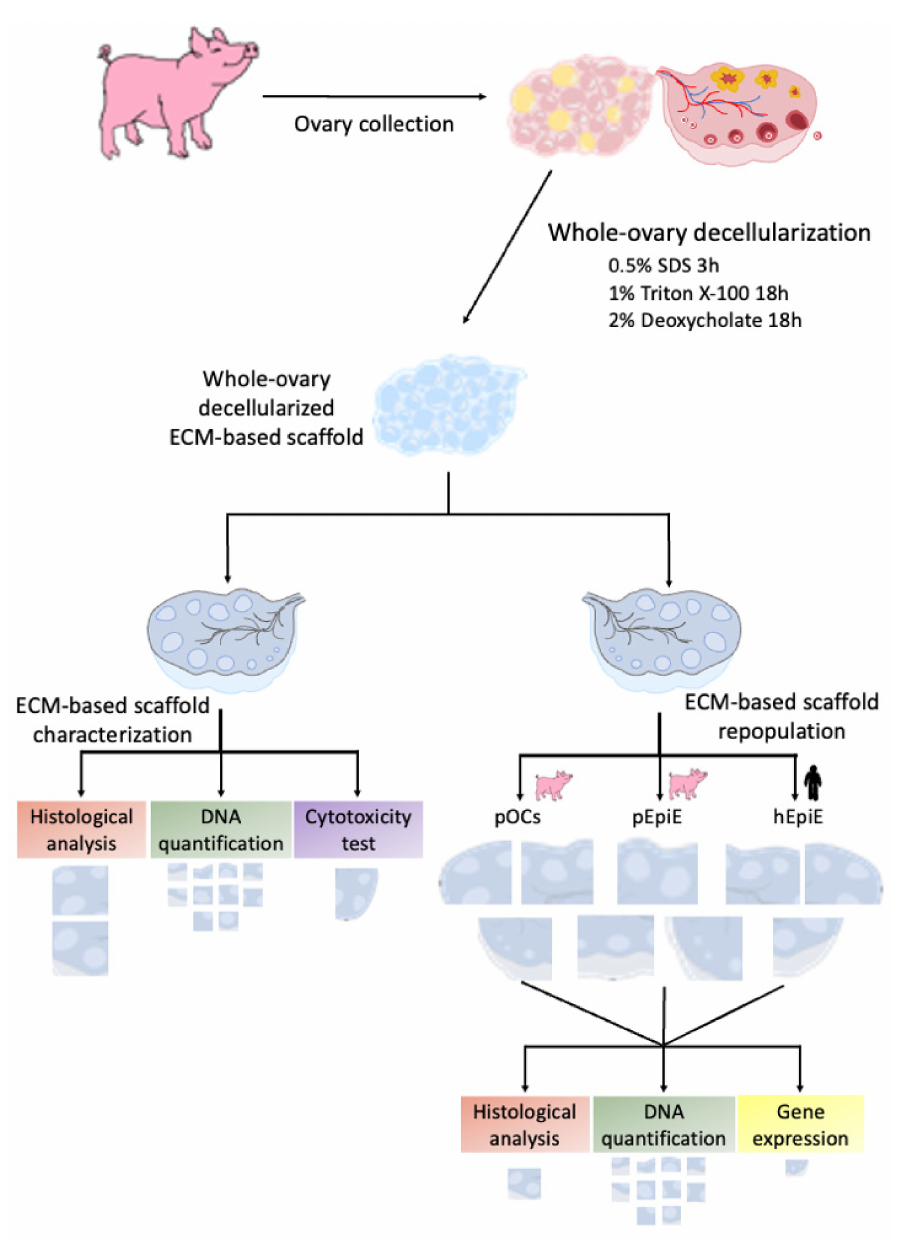
Figure 1. Scheme showing overall experimental